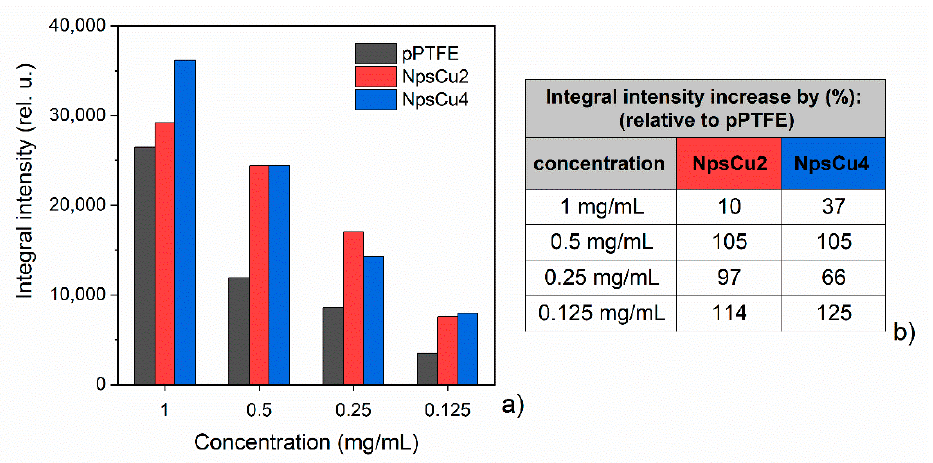
Figure 8. ( a ) Comparison of the integral intensity of averaged DPPC spectra in the region 2780–3020 cm − 1 for smooth pPTFE and nanorough NpsCu2, NpsCu4 substrates with ( b ) the integral intensity increase (in %) for nanostructured substrates relative to the smooth pPTFE substrate.